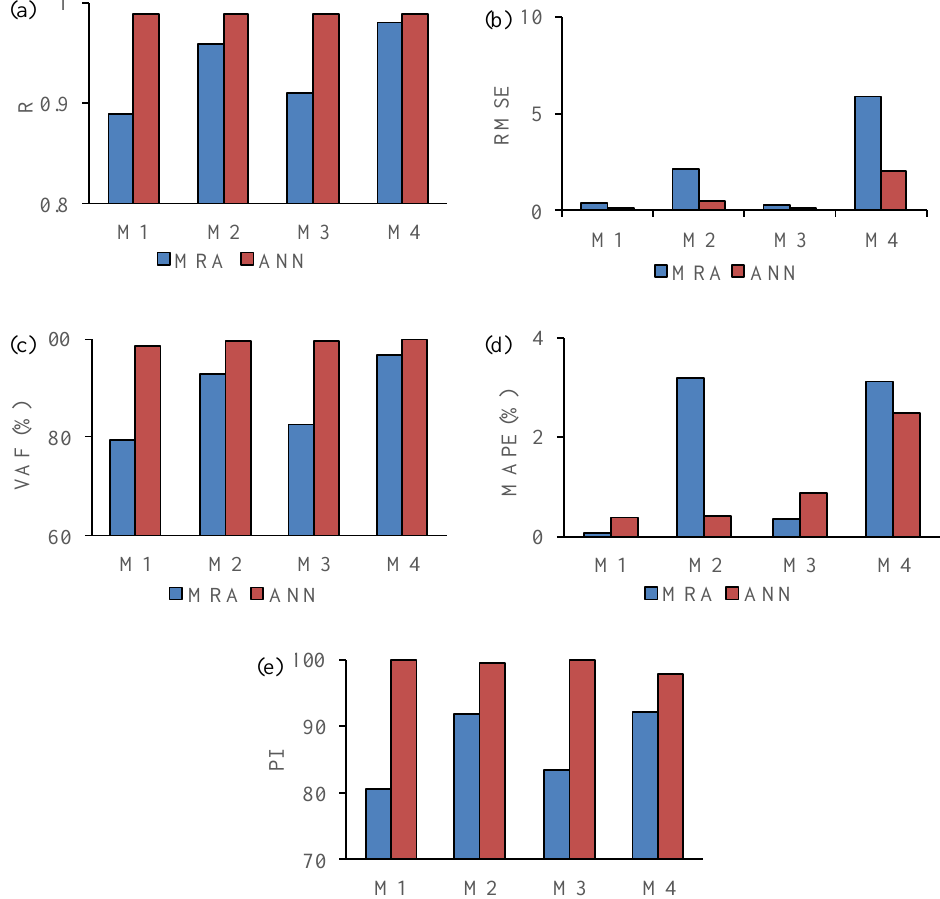
Figure 15. Comparative diagrams of statistical coefficients for results of MRA and ANN models ( a ) R, ( b ) RMSE, ( c ) VAF, ( d ) MAPE, and ( e ) PI.